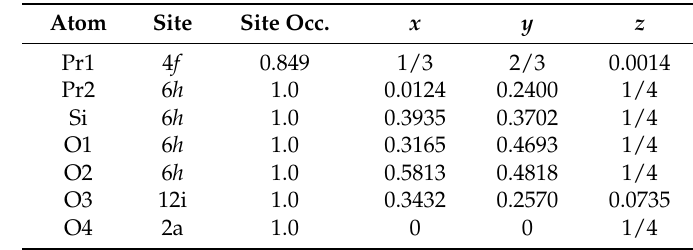
Table 1. Refined structural parameters for the as-grown PSO crystal according to P 6 3 /m model.